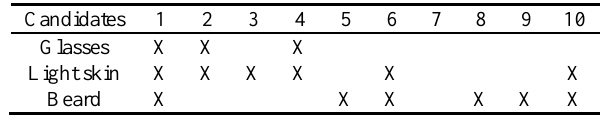
Table 1. Facial characteristics for the 10